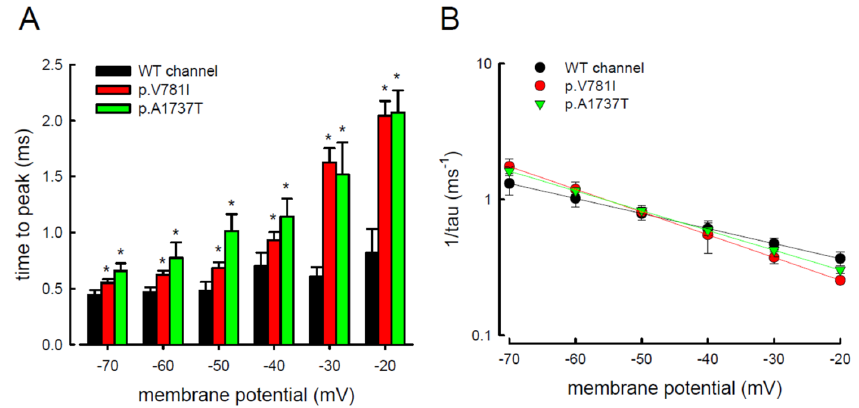
Figure 7. Slower time to peak of the resurgent Na + currents in the p.V781I and p.A1737T mutant channels. ( A ) The time to peak in resurgent Na + current was measured using the same protocol as in Figure 4. The value of time to peak plotted against the repolarization potentials for the WT and the p.V781I and p.A1737T mutant channels. The time to peak for the resurgent Na + current was significantly shorter in the WT channel than in the p.V781I and p.A1737T mutant channels, at variable repolarization membrane potentials between − 20 and − 70 mV (* p < 0.05). ( B ) The reciprocal time constants (1/tau) for the decay phase of resurgent Na + currents were plotted against the repolarizing potentials in semilogarithmic scales for the WT and the p.V781I and p.A1737T mutant channels. The lines were linear regression fitted using the formulas 1/tau (V) = 0.2 × exp( − 0.6 V/25) ms − 1 , 0.1 × exp( − 0.9 V/25) ms − 1 , and 0.1 × exp( − 0.8 V/25) ms − 1 for the WT and the p.V781I and p.A1737T mutant channels, respectively. “V” is the membrane potential in mV.